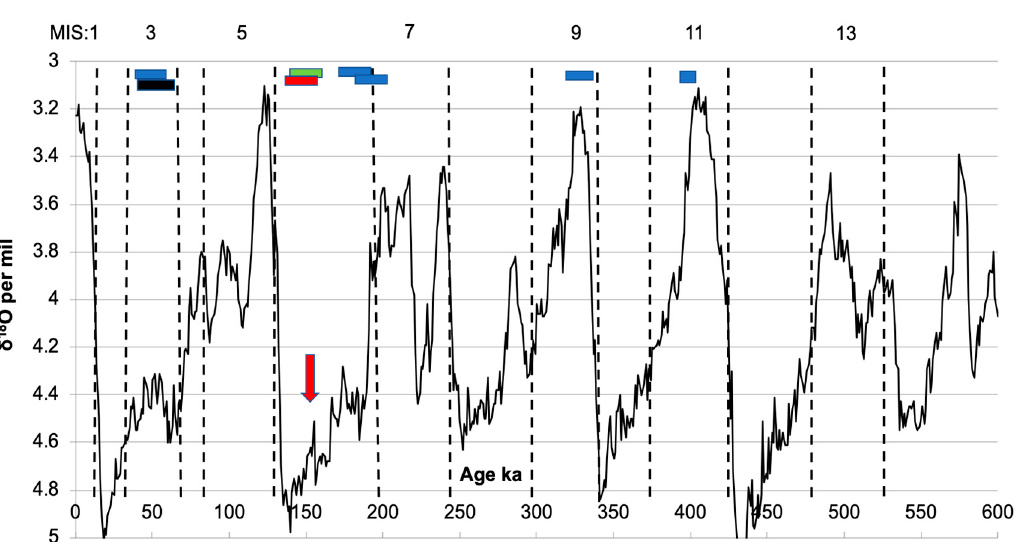
Figure 6. Comparison of alluvial fan and fluvial deposit ages from the interior of Oman. Every different color bar refers to different Quaternary deposits events as they have presented elsewhere. The present study age data is also included. Red bar: Ref. [21], black bar: Ref. [19], green bar: present study dating, blue bars: Ref. [20]. The LR04 stack of benthic δ 18 O from Ref. [36] was used for demonstrating MIS (Marine Isotope Stage) events. The numbers at the top of the figure indicating Marine Isotope Stages (MIS). Red arrow is showing slightly warmer period within MIS 6.